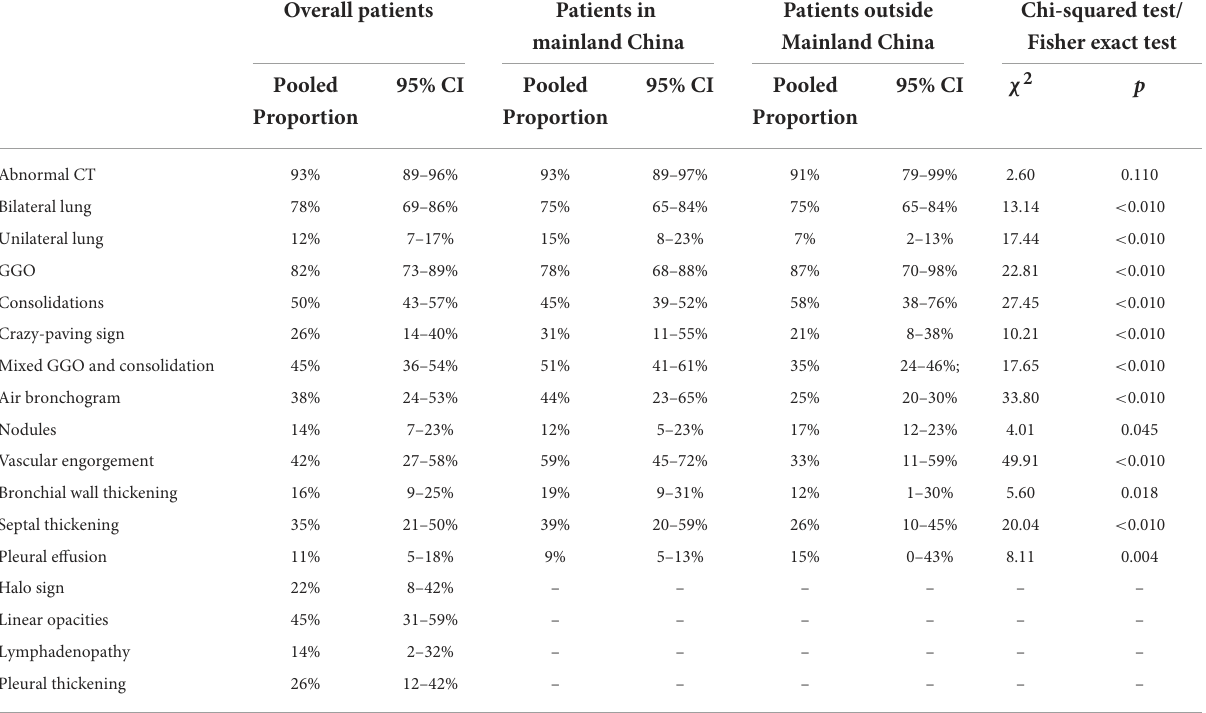
TABLE 1 Computerized tomography (CT) imaging findings in different analyses and comparisons in patients from within and outside mainland China. Overall patients